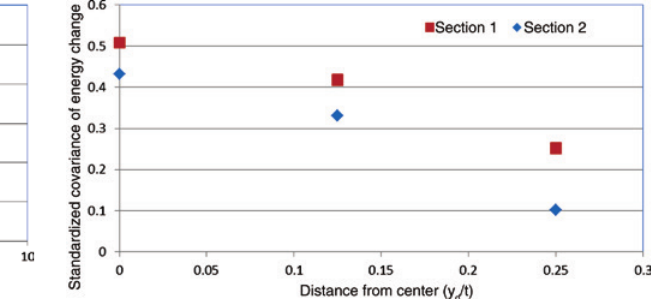
Figure 26: Covariance of energy change at Section 1 with varying damage depth.